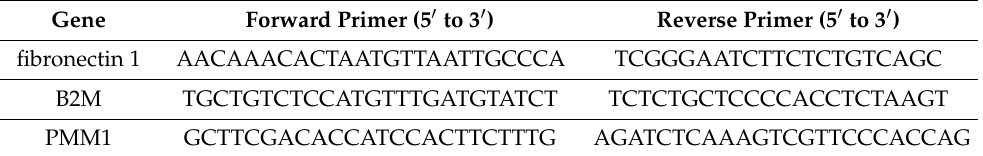
Table A1. Cont. Gene